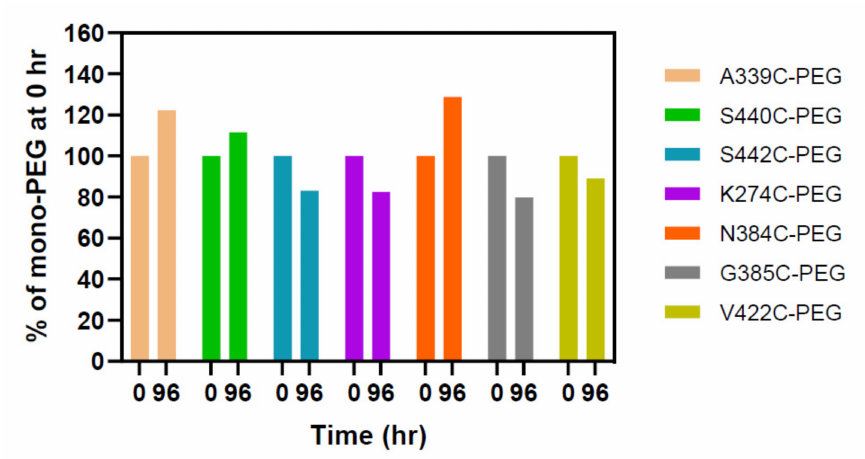
Figure 4. Plasma stability of PEGylated single cysteine mutants. The PEGylated antibodies were incubated with mouse plasma for 0 and 96 h before being analyzed using western blot with anti-PEG antibody. The percent of mono-PEG at 0 h represents the band area of mono-PEGylated species in the sample at 96 h divided by that at time 0, and then multiplied by 100.